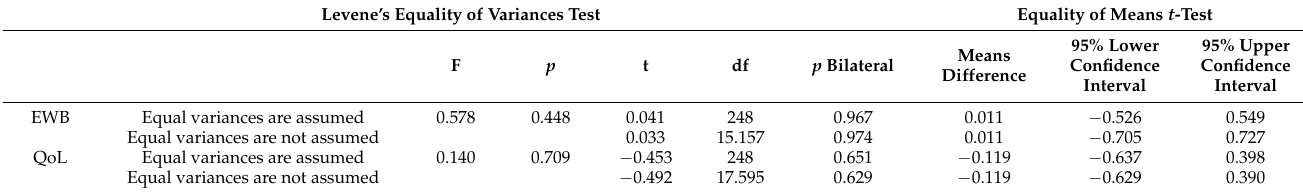
Table 7. Independent samples